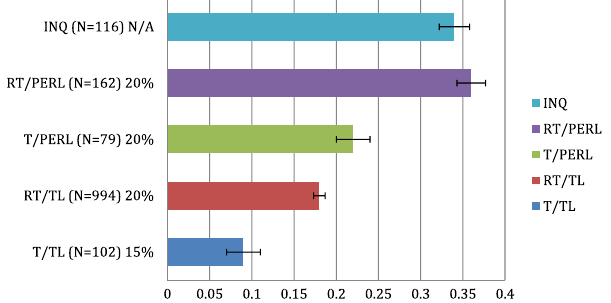
FIG. 1. Algebra-based FCI normalized gain by laboratory and teaching style. The data are listed by laboratory/teaching style ( N ¼ number of students ) percentage total grade allotted to laboratories plus recitation . Lab styles are labeled by traditional (T), Real Time Physics (RT), combination RT and T (RT-T), developed at the University of Illinois (IL), and locally written PER-informed (PER). The lecture teaching styles are labeled by traditional lecture (TL), PER-informed lecture (PERL), and inquiry-based instruction (INQ). Honors sections are labeled with an H .